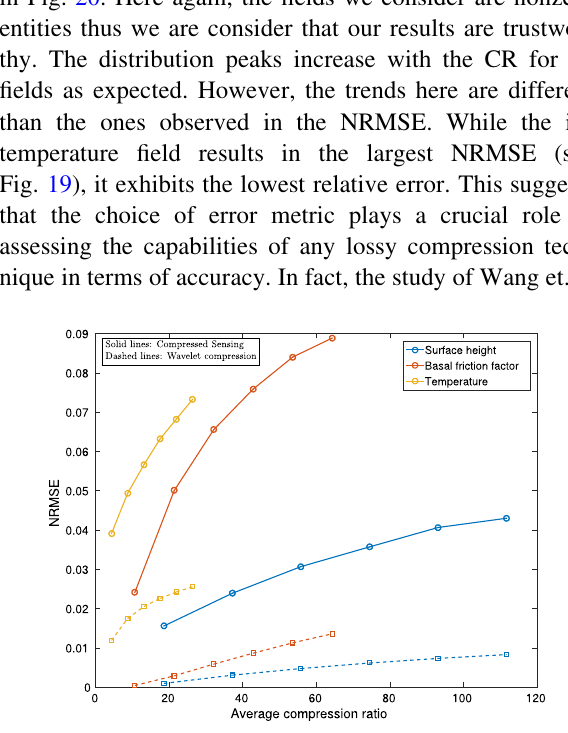
Fig. 19 Plots showing the variation of the global NRMSE between the original and decompressed indicated data fields as a function of the average compression ratio. All the fields are obtained from a Greenland ice sheet finite element simulation and are represented on an unstructured mesh with 2.8 million data points distributed on 64 processes. Results are reported for a local StOMP reconstruction from compressed samples and direct wavelet decompression with a wavelet order w ¼ 3 where the compression ratios were optimally